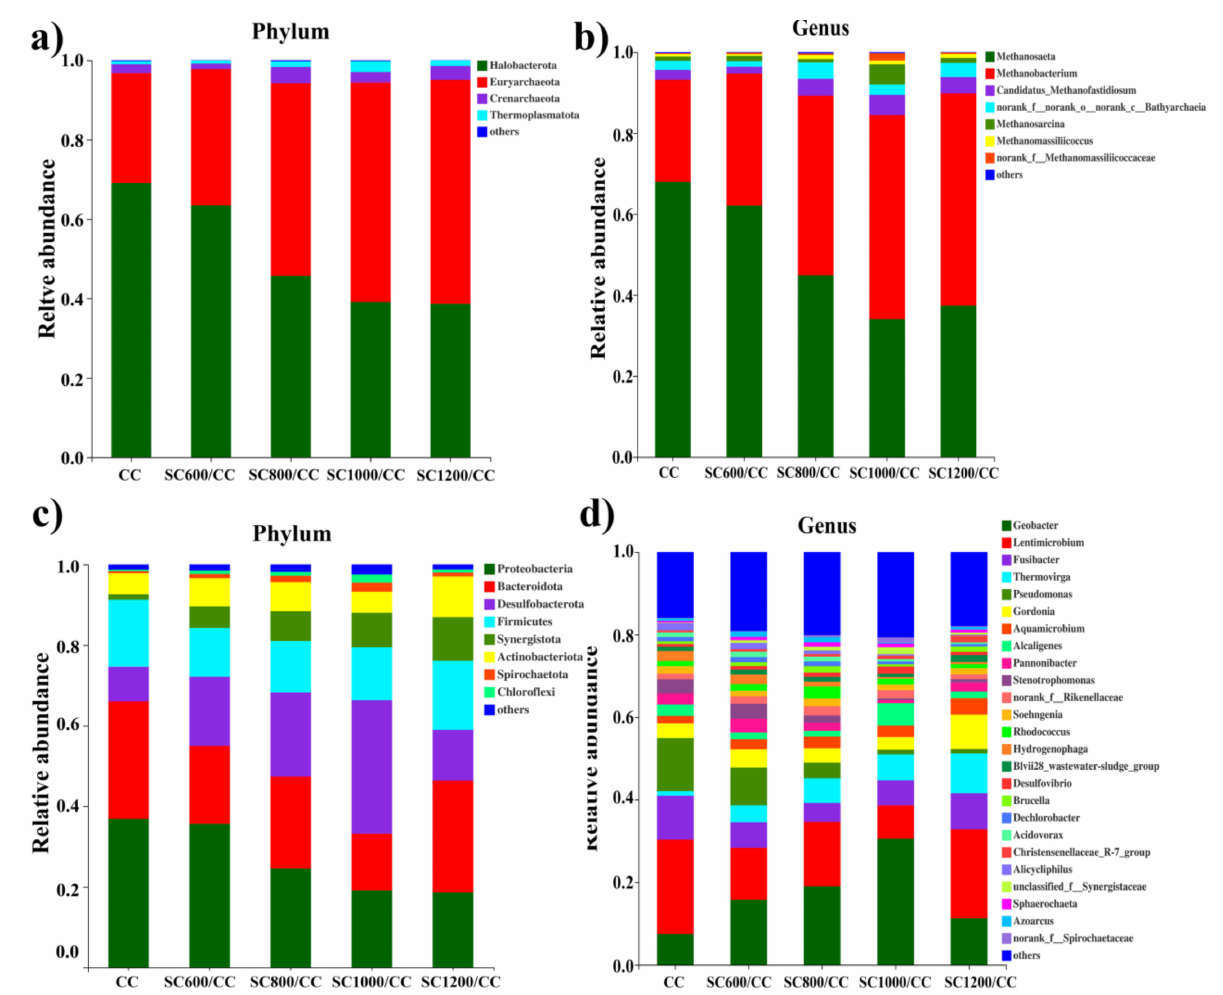
Figure 9. Microbial community structures of anodic biofilms of Archaea and bacteria attached on CC and SC anodes at the ( a , c ) phylum and ( b , d ) genus